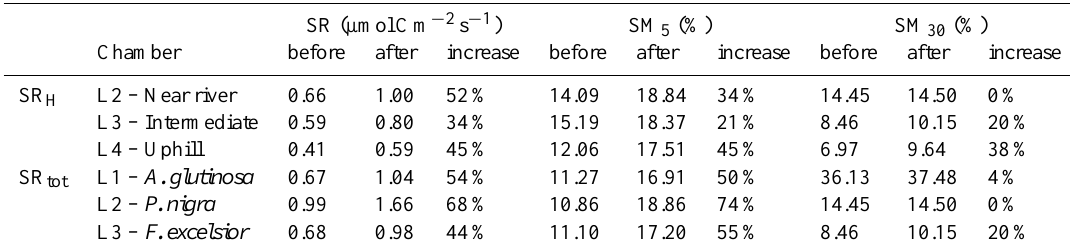
Table 3. Comparison of soil respiration rates (SR) and soil moisture (SM) after a rainfall event of 13.5mm in summer 2012. Heterotrophic SR (SR H ). Total SR (SR tot ). Five centimetre integral soil moisture (SM 5 ). Thirty centimetre integral soil moisture (SM 30 ). Data were averaged for the 2 days before and 2 days after the rainfall